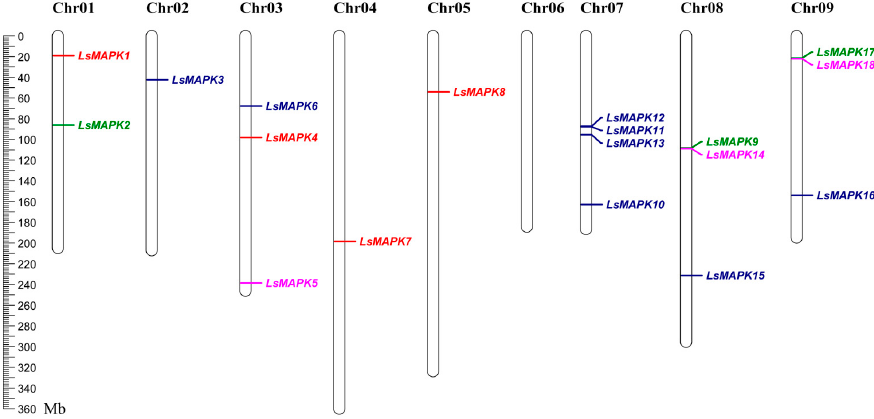
Figure 4. Chromosomal distribution of LsMAPK genes in lettuce chromosomes. Different colors represent different subfamily LsMAPK genes.